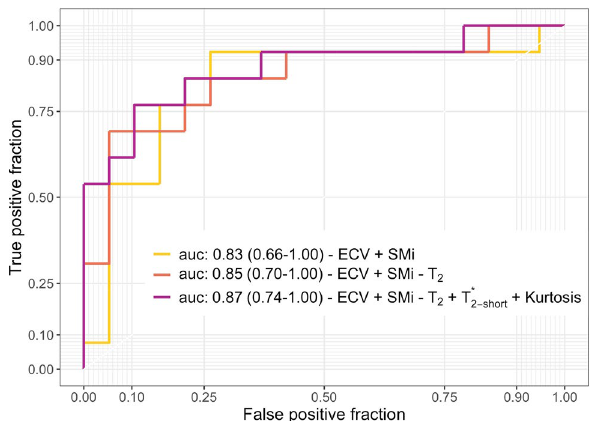
Figure 7. Combining non-invasive metrics to assess skeletal muscle fibrosis. Combining ECV and SMi (light orange line), ECV, SMi and T 2 estimated from MSME data (red line) or ECV, SMi, T 2 (MSME), short-T 2 * and Kurtosis (purple line) lead to AUCs always above 0.8. The combination of NMR and SWE metrics improved the ability to distinguish fibrotic (total collagen fraction from 15 to 25%) from non-fibrotic muscles (total collagen fraction up to 14%) non-invasively. Values are presented as AUC (95% confidence